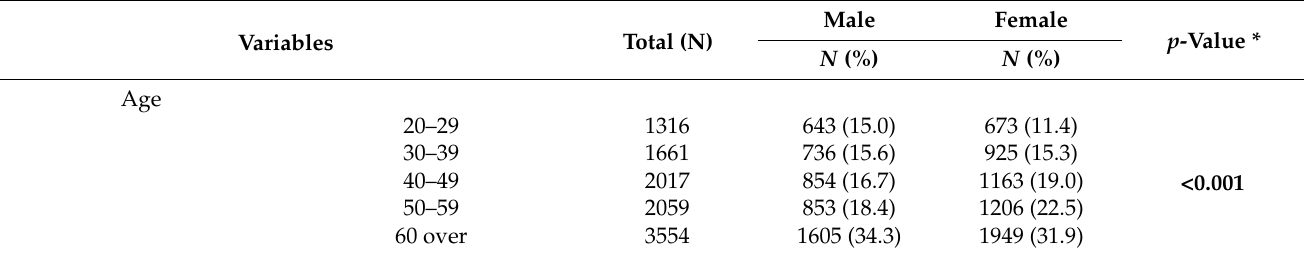
Table 1. General characteristics according to